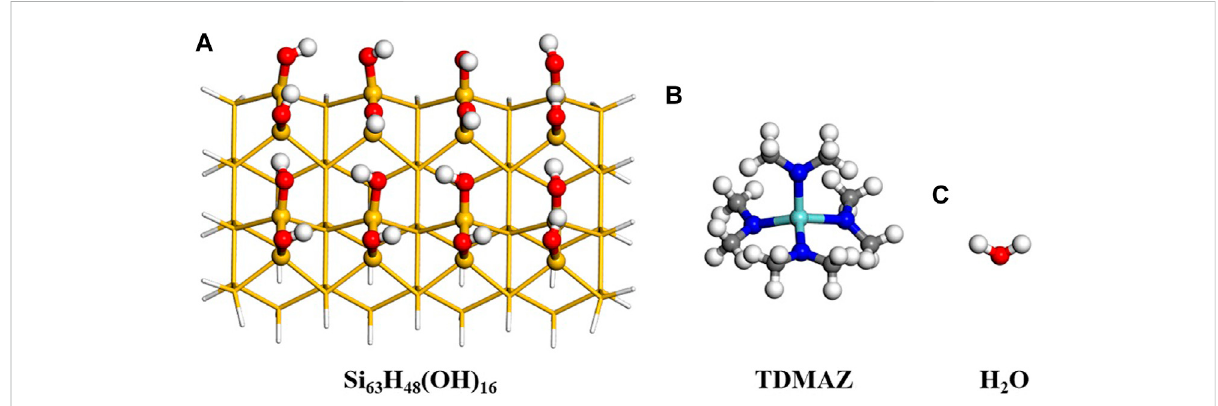
FIGURE 2 Surface model for Si 63 H 48 (OH) 16 , TDMAZ and H 2 O. The yellow, red, white, blue and light blue balls represent Si, O, H, N and Zr atoms,